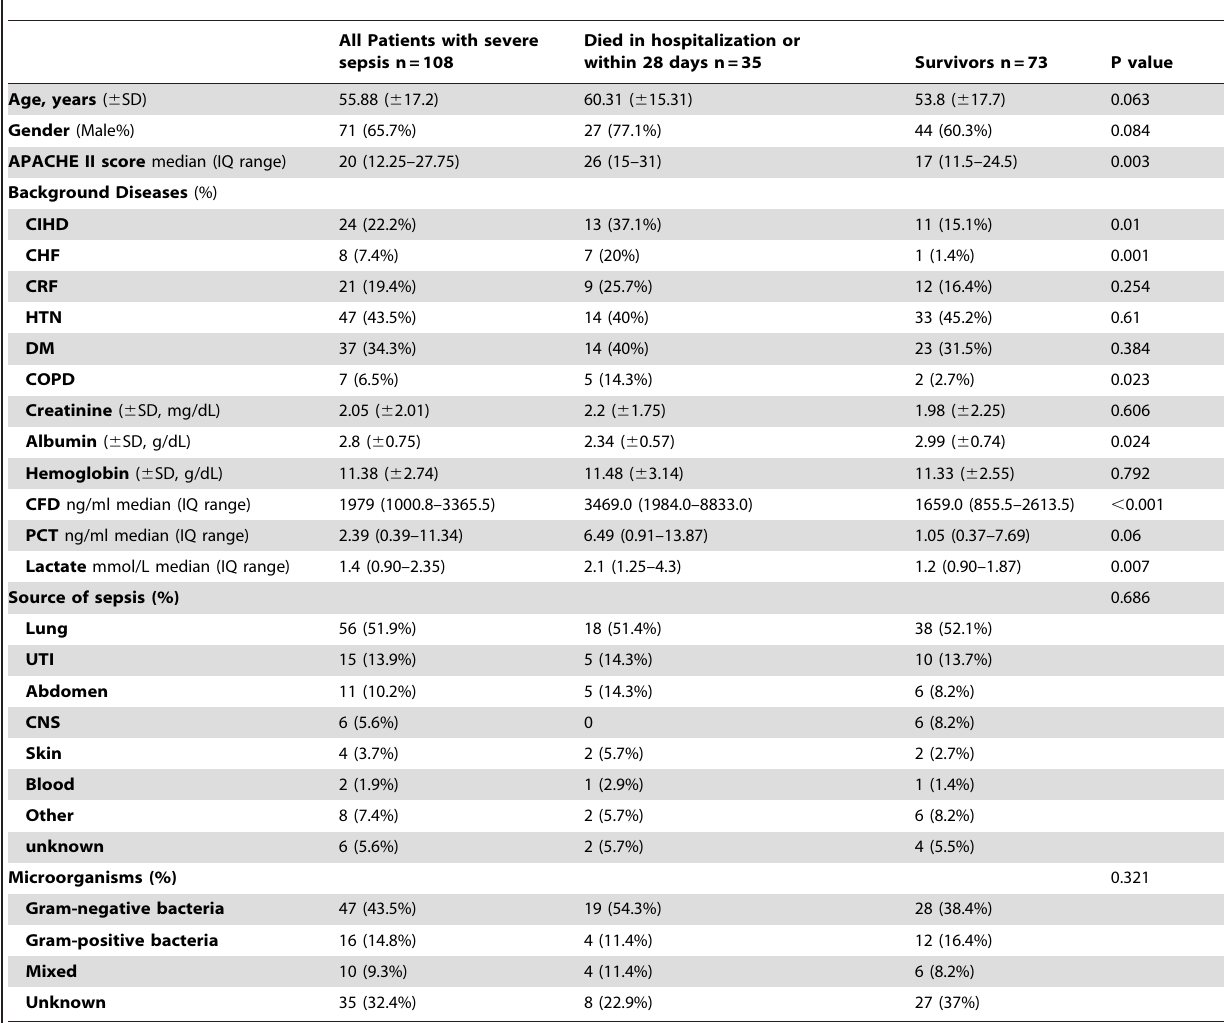
Table 1. Patient demographics and clinical data at